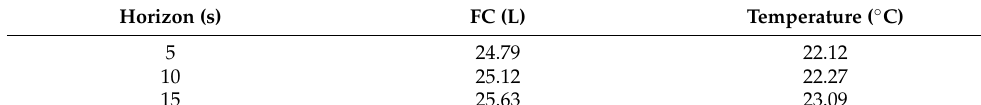
Table 3. Results of PMP-MPC with three prediction horizons in driving cycle B.